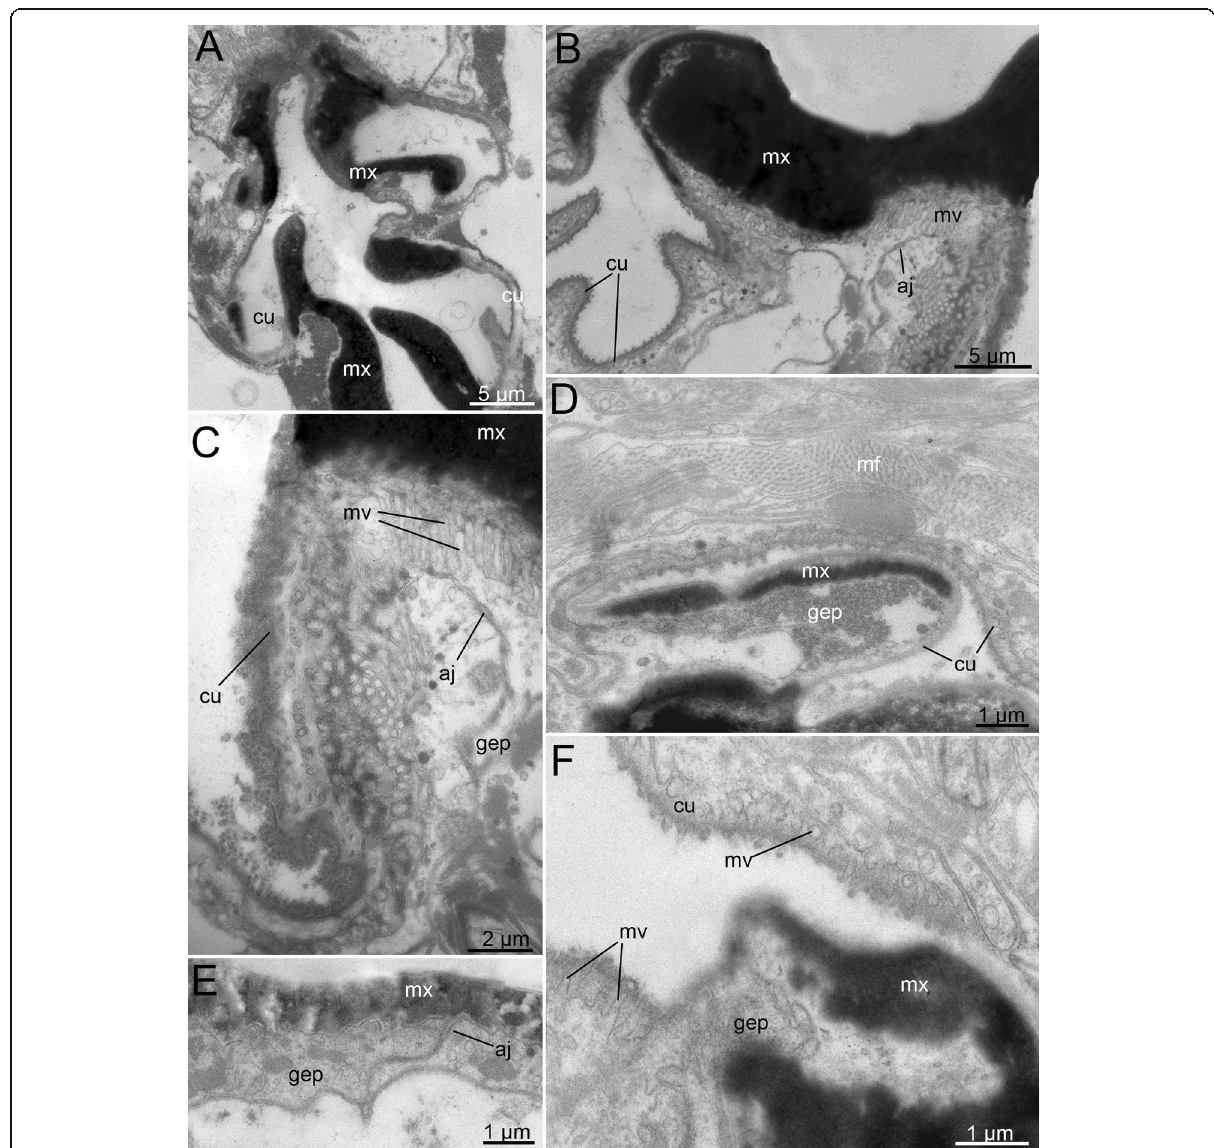
pharyngeal cuticle; gep, gnathoepithelial cell; mf, myofilament; mv, microvilli; mx,